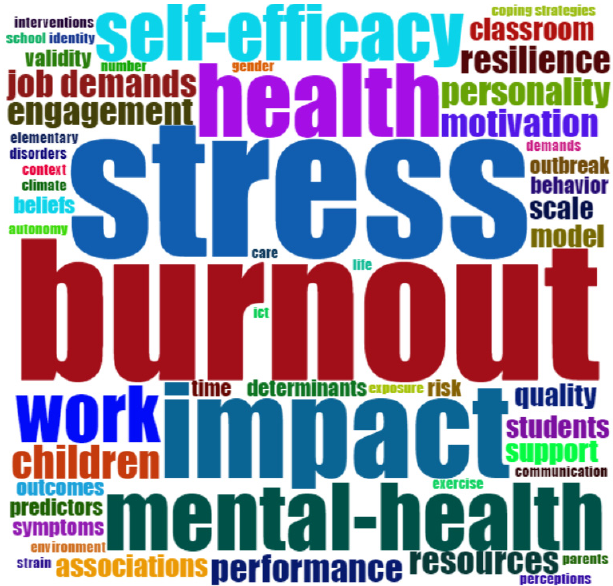
Figure 7. Most frequent words (frequency ≥ 3).